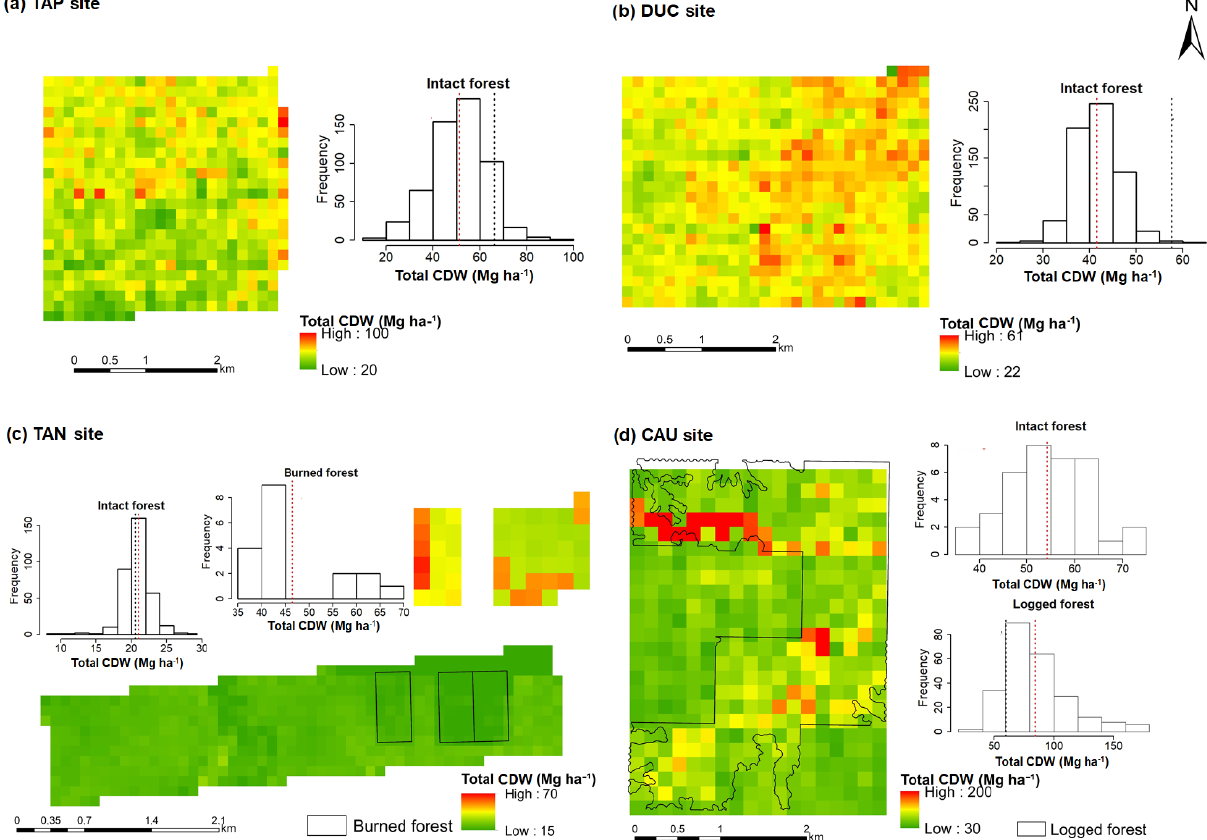
Figure 5. Wall-to-wall maps and histograms of total CDW predicted by lidar-only models at landscape level (166m resolution). For intact forest at the Tapajós National Forest (a) the predicted mean was 51 . 3 ± 11 . 8Mgha − 1 (red dotted line) and the field-based mean from our database was 66 . 2 ± 20 . 0Mgha − 1 (black dotted line). For intact forest at Reserva Adolpho Ducke (b) the predicted mean was 41 . 6 ± 5 . 0Mgha − 1 and the field-based mean from our database was 57 . 6 ± 20 . 0Mg ha − 1 . For intact forests at Fazenda Tanguro (c) the predicted mean was 21 . 0 ± 2 . 0Mgha − 1 and the field-based mean was 20 . 6 ± 1 . 8Mgha − 1 . For burned forests (highlighted as a second panel in the CDW map) the predicted mean was 46 . 5 ± 9 . 8Mgha − 1 and the field-based mean was 32 . 5 ± 6 . 0Mgha − 1 . For intact forests at Fazenda Cauaxi (d) the predicted mean was 54 . 2 ± 8 . 8Mgha − 1 and the field-based mean was 33 . 2 ± 10 . 0Mgha − 1 . For logged forests the predicted mean was 84 . 6 ± 27 . 5Mgha − 1 and the field-based mean was 60 . 3 ± 24 . 0Mgha − 1 ; high CDW areas in the northern portion of the image are associated with the main road through the logging site. Red dotted lines indicate the predicted mean by the lidar-only model, and black dotted lines indicate the field-based mean from the sample transects and inventory